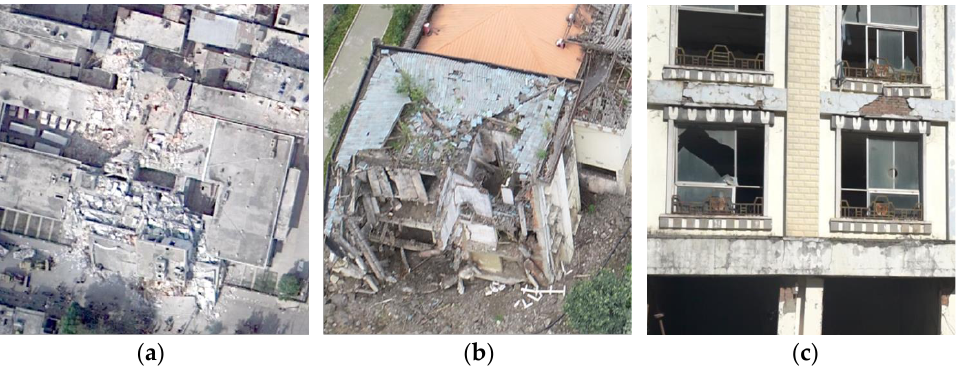
Figure 1. The difference in multi-granularity damage characteristics from satellite images ( a ), drone footage ( b ), and terrestrial images ( c ).